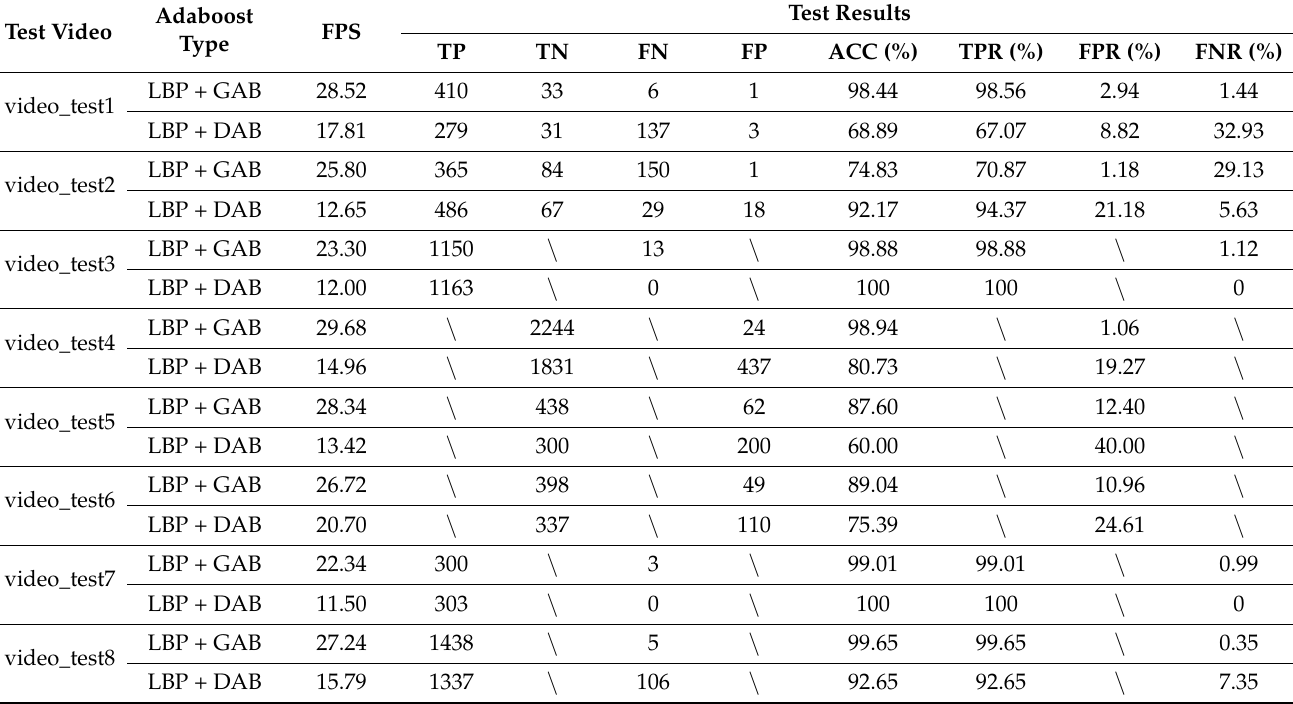
Table 7. Based on test videos test